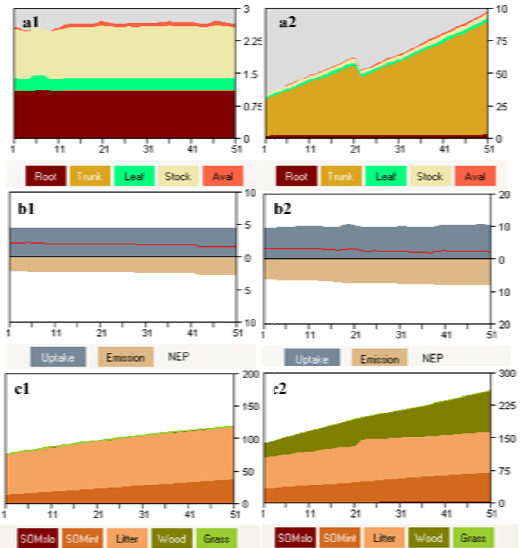
Fig.3. Comparative magnitudes of Euclide different vegetation types in Western Him (a) normal (2006) and (b) warm (2009) yea